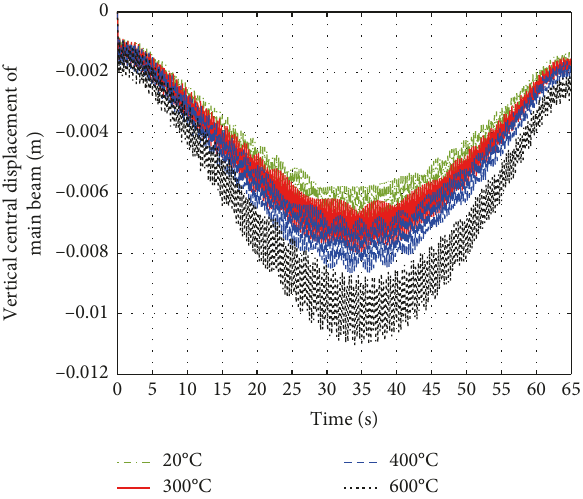
Figure 11: Displacement response of the main beam at different